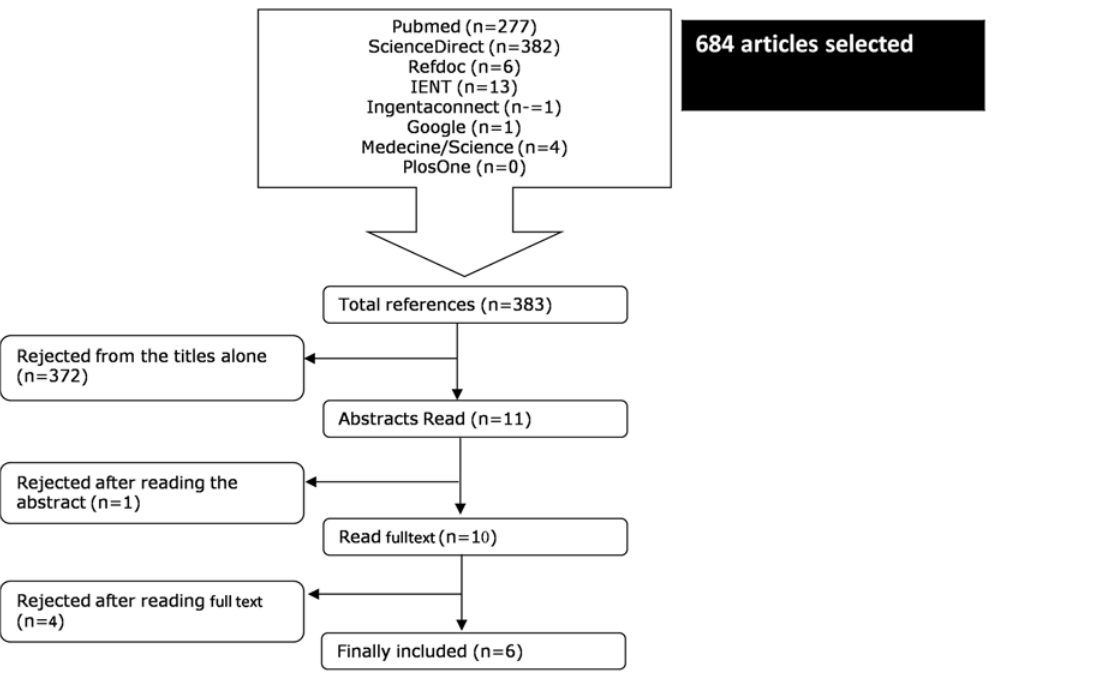
Fig 1. Flowchart of search of studies for epidemiological correlation between toxoplasmosis and epilepsy.